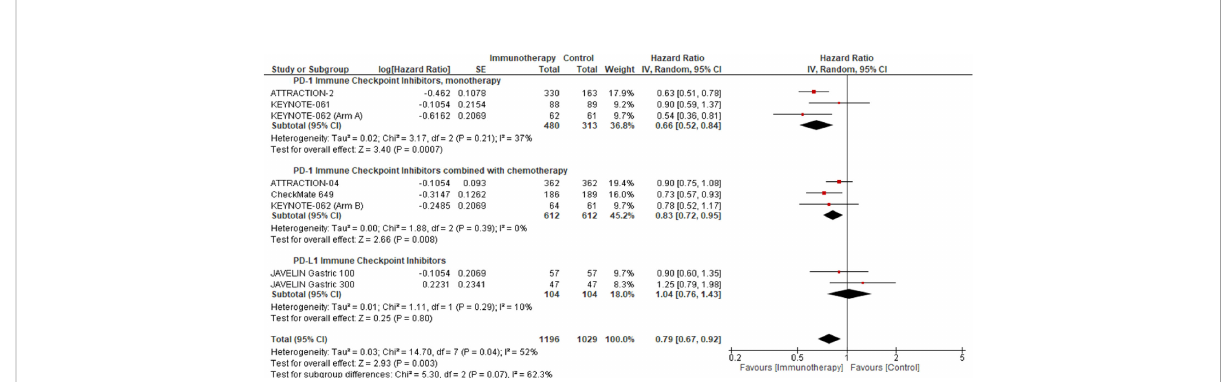
FIGURE 2 Overall survival response analysis of ICIs in the Asian patient population. This fi gure illustrates the pre-planned sensitivity analysis forest plot to demonstrate the impact of ICI as monotherapy or in combination with the comparator on the median overall survival in Asian patients ’ intention to treat